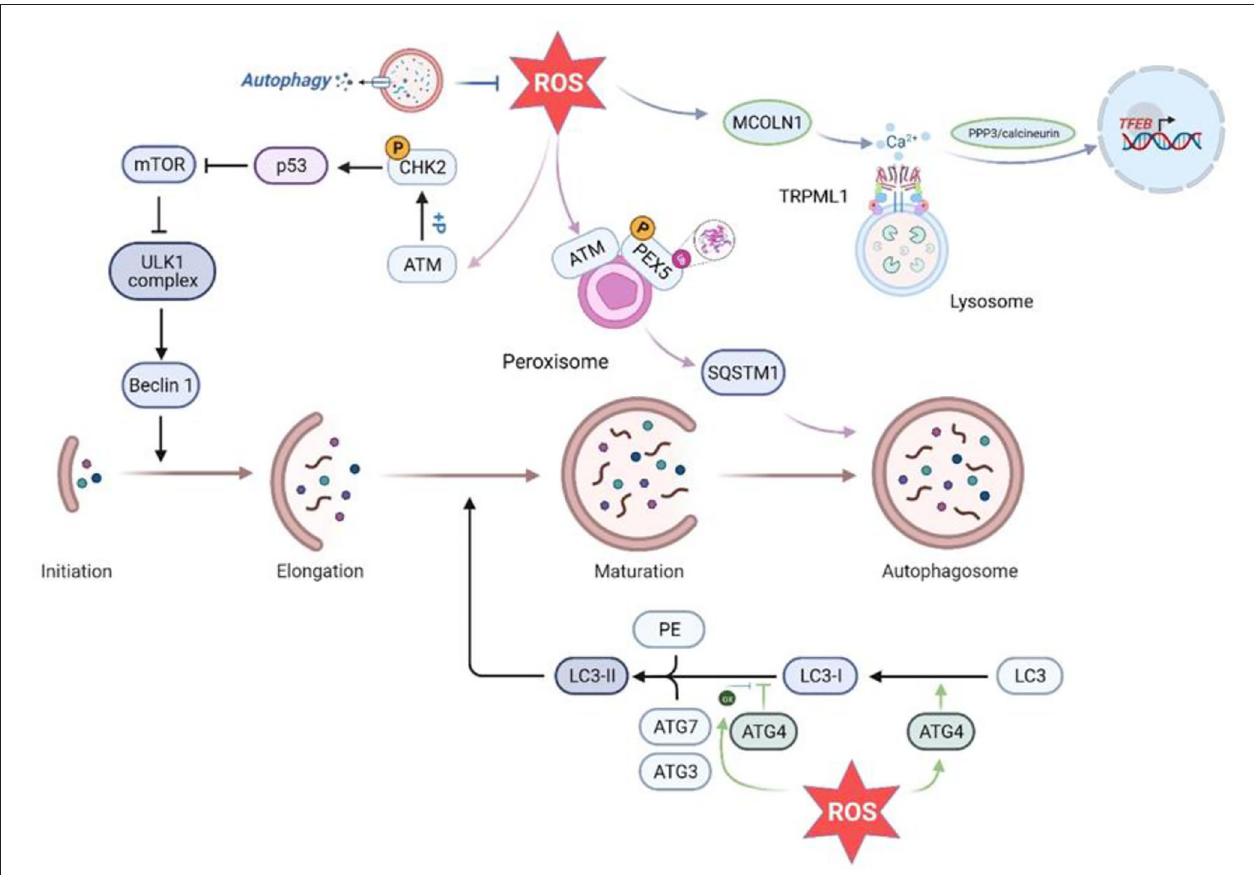
FIGURE 3 | Effects of ROS on various aspects of autophagy. ROS promote autophagy initiation by activating ATM to phosphorylate Chk2 at Ser90/Ser93, which in turn inhibits mTOR. In addition, in the peroxisome, PEX5 is phosphorylated and ubiquitinated in an ATM-dependent manner activated by ROS, promoting autophagy by enhancing SQSTM recognition of the cargo ( 95). In addition, increased ROS inhibit ATG4-mediated LC3 delipidation and promote autophagic vesicle maturation. Higher levels of ROS lead to ATG4 oxidation and inhibit ATG4 deconjugation of LC3 to allow phagosome expansion and promote autophagic membrane formation. Increased intracellular ROS levels can directly activate Ca 2 + channels in the lysosomal membrane (MCOLN1/TRPML1), inducing Ca 2 + release and triggering PPP3/calcineurin-dependent TFEB nuclear translocation to promote autophagy. ROS, reactive oxygen species; ATM, ataxia-telangiectasia mutant; CHK2, cell cycle checkpoint kinase 2; PEX5, peroxisome import receptor; SQSTM1, sequestosome1; ATG, autophagy-related gene; PE, phosphatidylethanolamine; MCOLN1, mucolipin 1;TRPML1, Transient Receptor Potential Cation Channel Subfamily;PPP3, protein phosphatase 3;TFEB, transcription factor